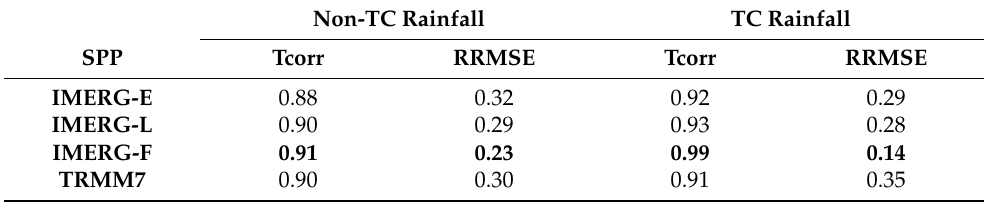
Figure 8. Interannual variation of ( a ) non-TC rainfall and ( b ) TC rainfall accumulated from July to October and area- averaged over Taiwan within the period of 2000 – 2018. Horizontal distribution of point-to-point Tcorr between CWB and selected SPPs for the interannual variation of ( c ) non-TC rainfall and ( d ) TC rainfall during 2000 – 2018 JASO. Tcorr values that pass the 99% significance t-test are marked by dots in ( c , d ). Table 5. Statistical values for the comparison of the interannual variation in rainfall between CWB and SPPs shown in Figure 8a,b. Values closest to perfect scores (Tcorr ~1 and RRMSE ~0) are bold.